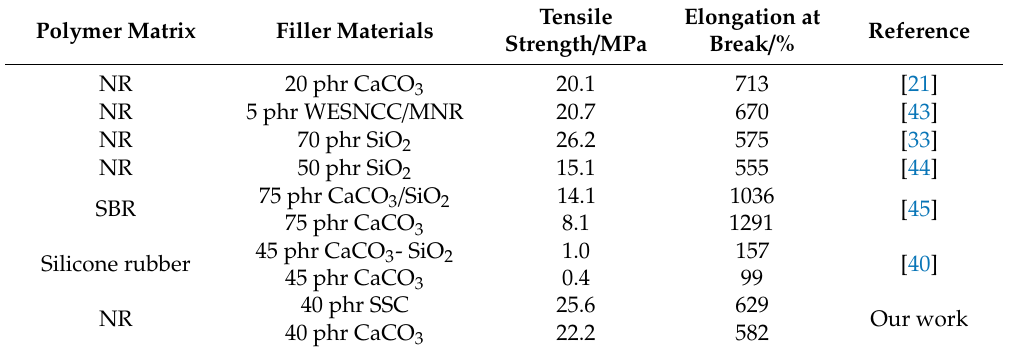
Table 4. Comprehensive analysis of various composites and its tensile strength and elongation at